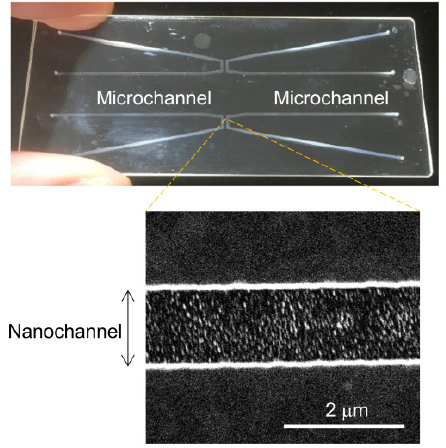
Figure 3. Images of fabricated device and nanochannel for streaming-current measurements.